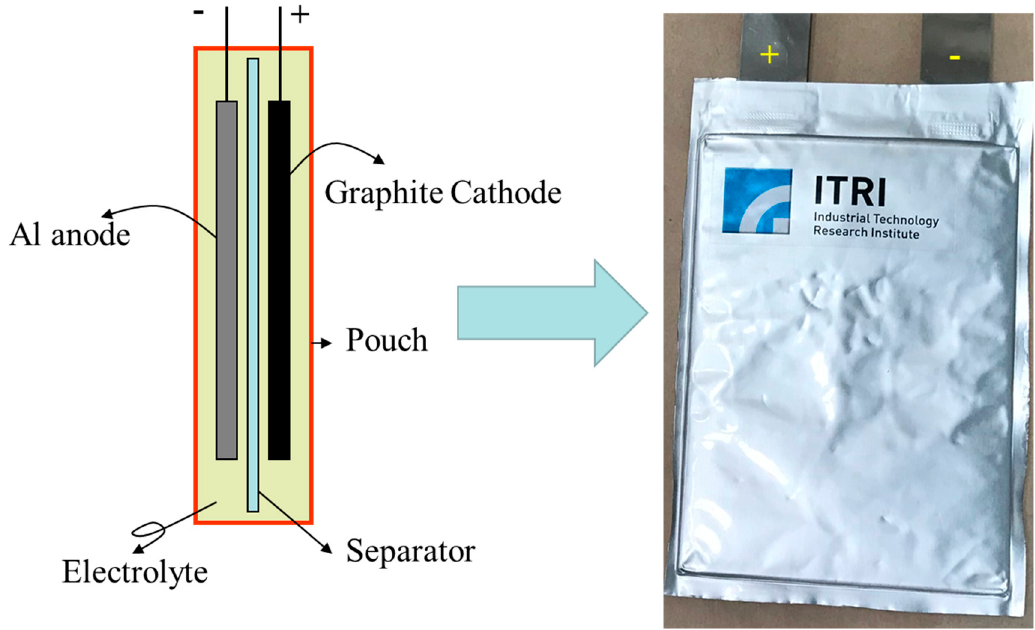
Figure 1. Demonstration of graphite-based Al secondary battery (GAB) pouch cell fabrication.